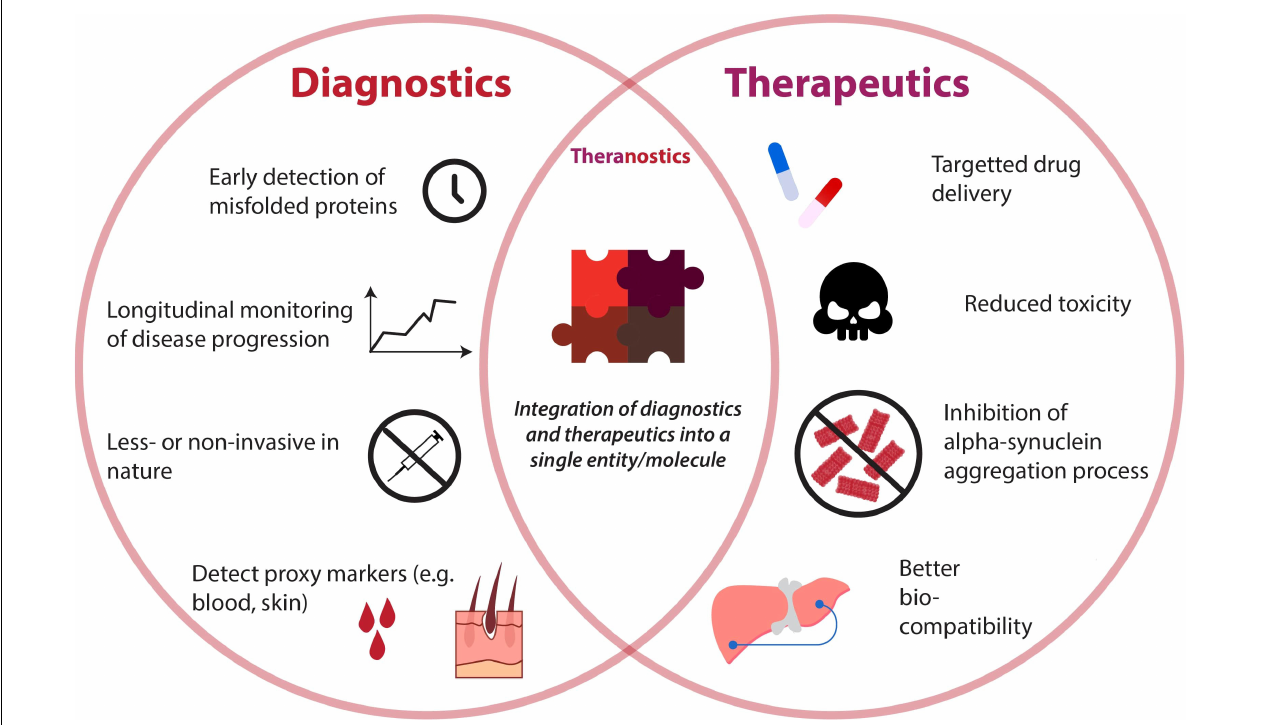
FIGURE 3 | Venn diagram depicting attributes of diagnostics and therapeutics for detection and reduction of alpha-synuclein aggregates. A unison of both diagnostic and therapeutic capabilities gives rise to the booming field of “theranostics,” whose properties are also